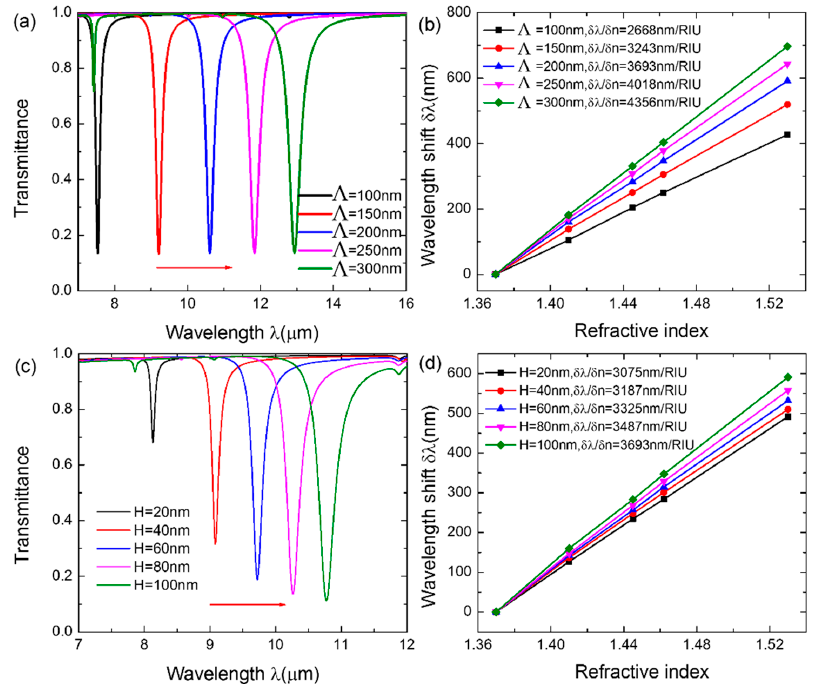
Figure 2. ( a ) Transmission spectra with varying Λ when H = 100 nm and W = 100 nm. ( b ) The calculated sensitivity when Λ = 100 nm, 150 nm, 200 nm, 250 nm, and 300 nm, respectively. ( c ) Transmission spectra with varying H when Λ = 200 nm and W = 100 nm. ( d ) The calculated sensitivity when H = 20 nm, 40 nm, 60 nm, 80 nm, and 100 nm, respectively. The lines in ( b ) and ( d ) are linear fittings to the data.